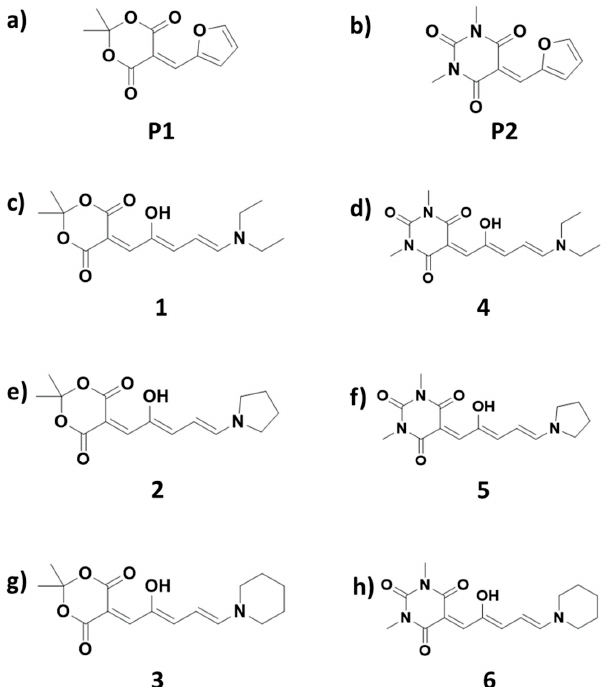
Figure 1. First-generation DASA compounds were prepared from precursors P1 and P2 ( a , b , respec- tively). DASAs subject to voltammetry and UV-vis SEC analyses are designated as 1 – 6 ( c – h ).